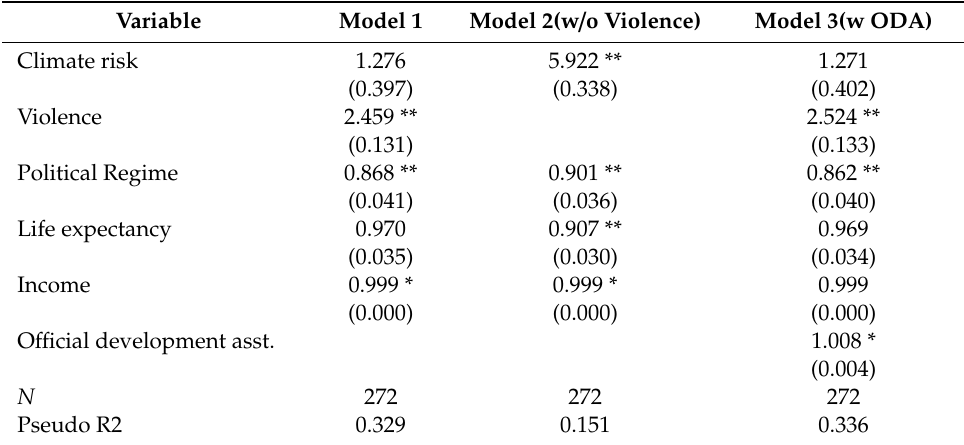
Table 1. Ordered logistic regression (odds ratios presented) of large-scale forced